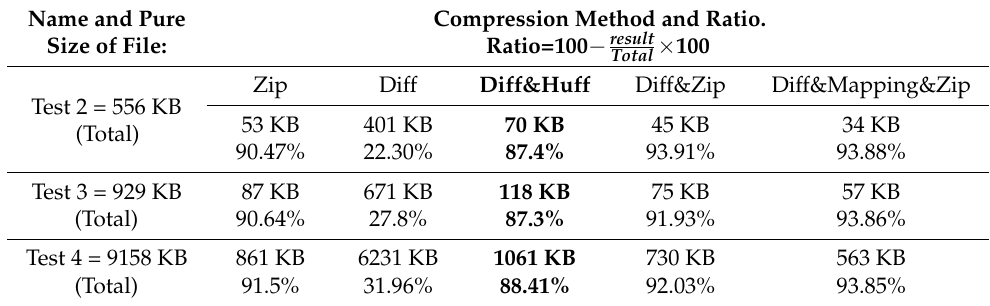
Table 2. Comparison between different compression methods–source files are 556 KB–9158 KB.